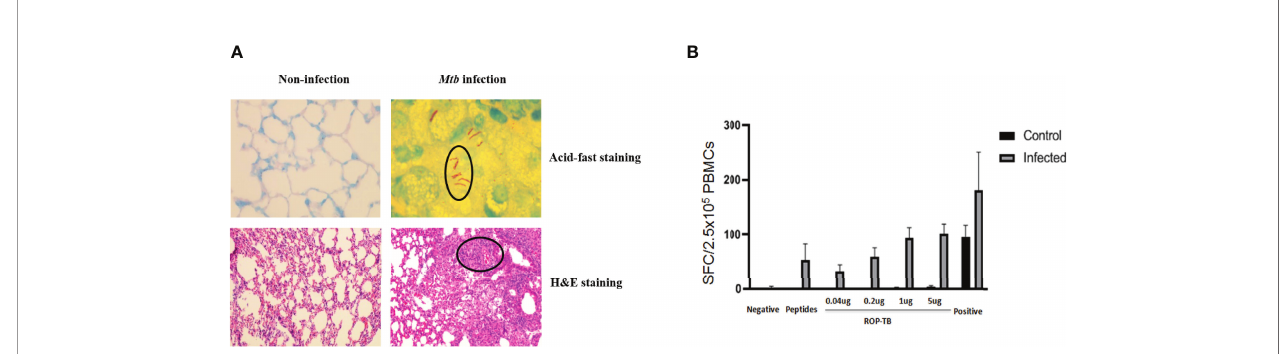
FIGURE 3 | ROP-TB stimulates speci fi c T cell immune response in the Mtb- infected mouse model (A) Establish Mtb- infected mouse model by intranasal infection of Mtb . Upper panels: acid-fast staining of lung alveolar in noninfected (left) and infected (right) mice. Mtb are observed in the lung (circled) only in infected mice (right). Lower panels: H&E staining of histopathological changes of the lungs in non-infected mice (left) and infected mice (right). Marked lymphocyte in fi ltration in the interstitial and alveolar space is present only in infected mice (right) together with pulmonary edema, alveolar distortion, and thickening of the alveolar wall. (B) Speci fi c T cell responses of infected mice. Responses of spleen cells from noninfected (control) and infected mice to different doses of ROP-TB are only seen in infected mice. Negative control: culture medium (R10); stimulant: peptides (5 m g/well); ROP-TB with 4 different doses (0.04, 0.2, 1 and 5 m g/well); Positive control: PHA (5 m g/well).